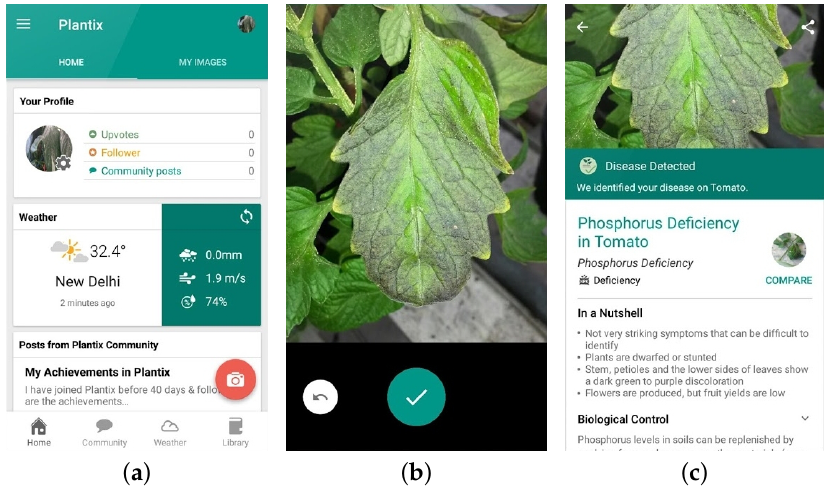
Figure 2. Plantix: ( a ) Main menu; ( b ) Capture image interface; ( c ) Image processing result.